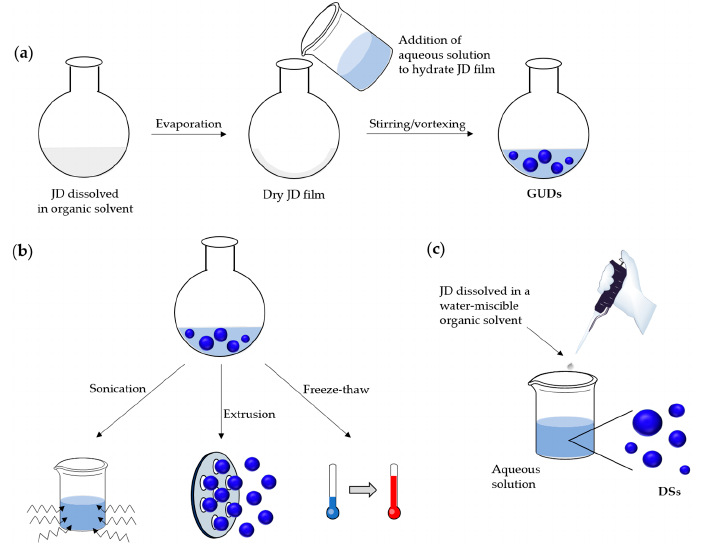
Figure 8. ( a ) Film rehydration method for the preparation of GUDs; ( b ) post-preparation methods